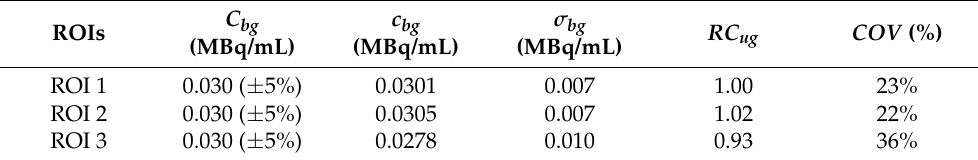
Table 3. Calibration factors assessed for the homogeneous phantom. 𝐶 𝑏𝑔 represents the known ac- tivity concentration in the phantom, 𝑐 𝑏𝑔 is the measured activity, 𝜎 𝑏𝑔 is the standard deviation of the activity concentration values, 𝑅𝐶 𝑢𝑔 is the recovery coefficient of the cylindrical phantom and COV is the coefficient of variation.